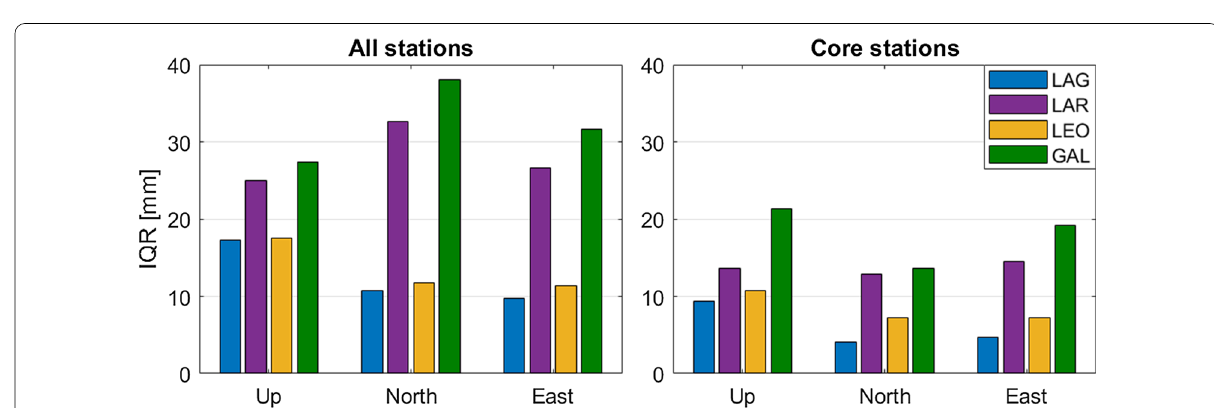
Fig. 8 Repeatability of estimated station coordinates by means of IQR from single satellite-type solutions for all SLR stations (left), and core SLR stations (right)